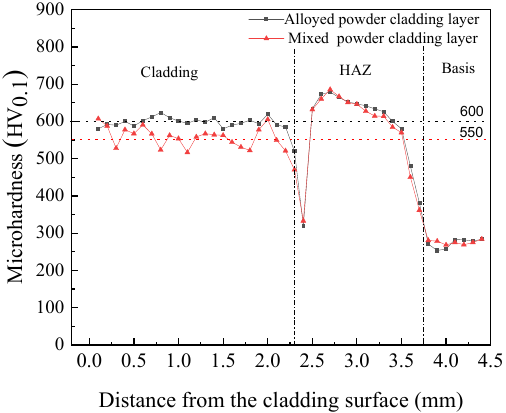
Figure 11. Microhardness of the two cladding layers.